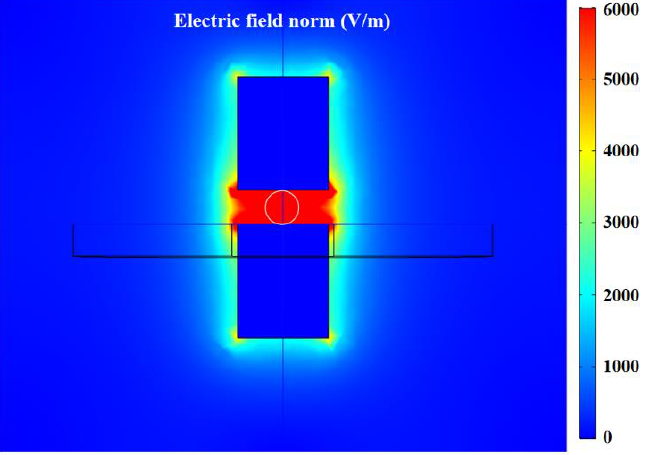
Figure 4. Distribution characteristic of electric field in detection region.